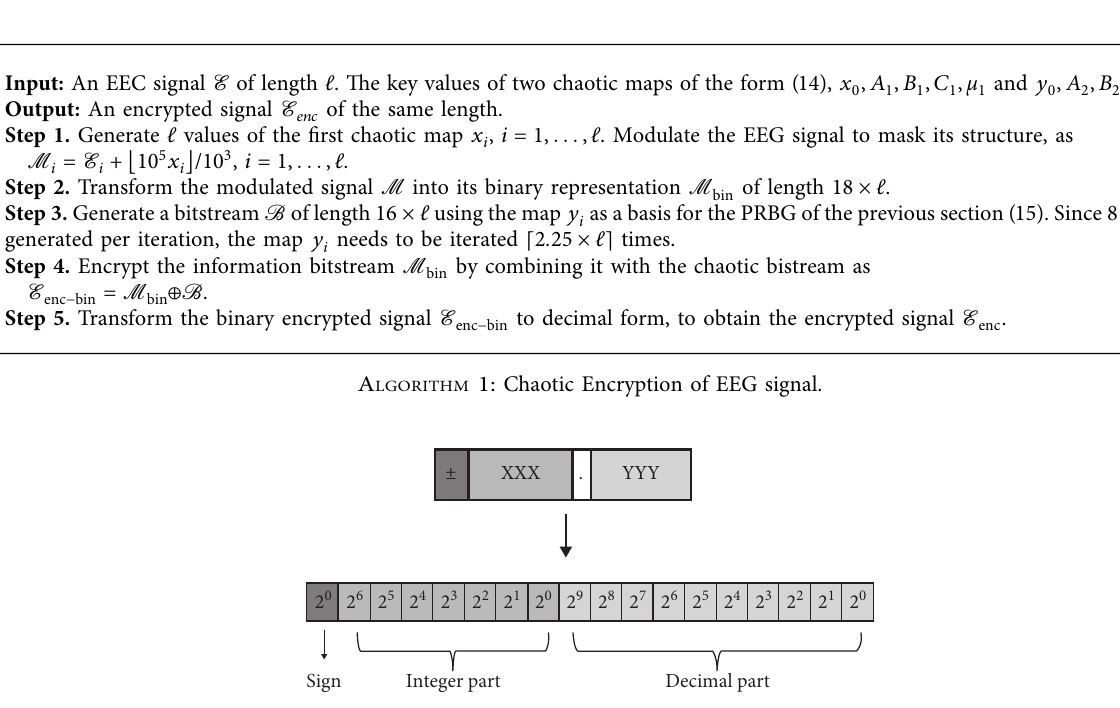
� 0 . 1 (blue), x � − 0 . 1 (red). 0 0